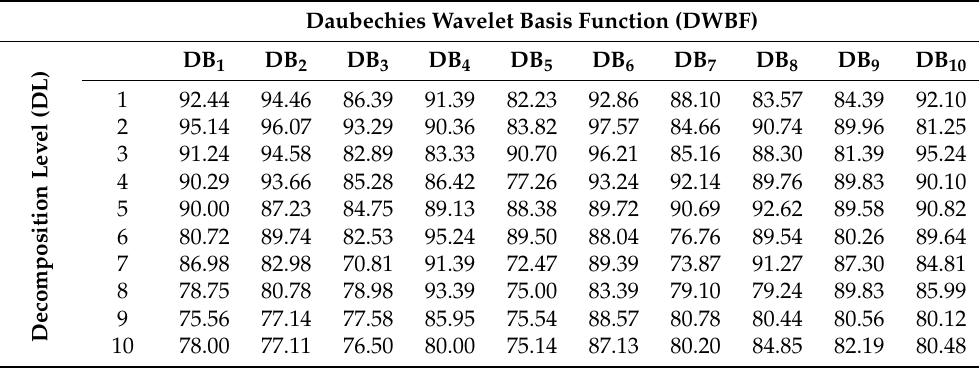
Table 6. Average sensitivity (%) due to DWBF and decomposition level (DL).